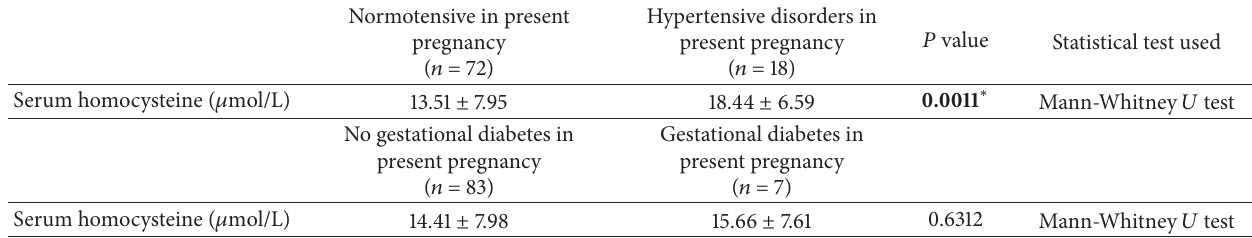
Table 3: Homocysteine levels with reference to maternal outcome of present pregnancy.